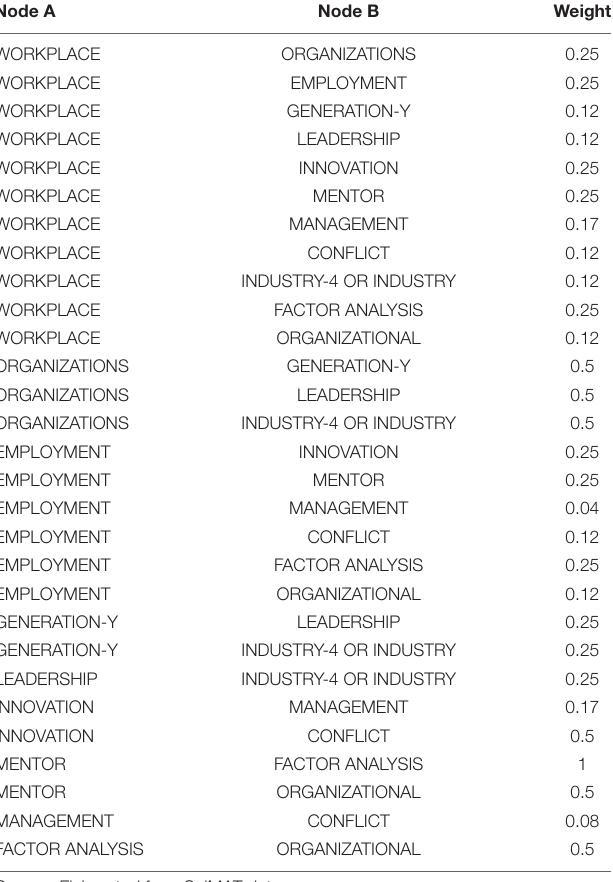
TABLE 9 | “Workplace” cluster network